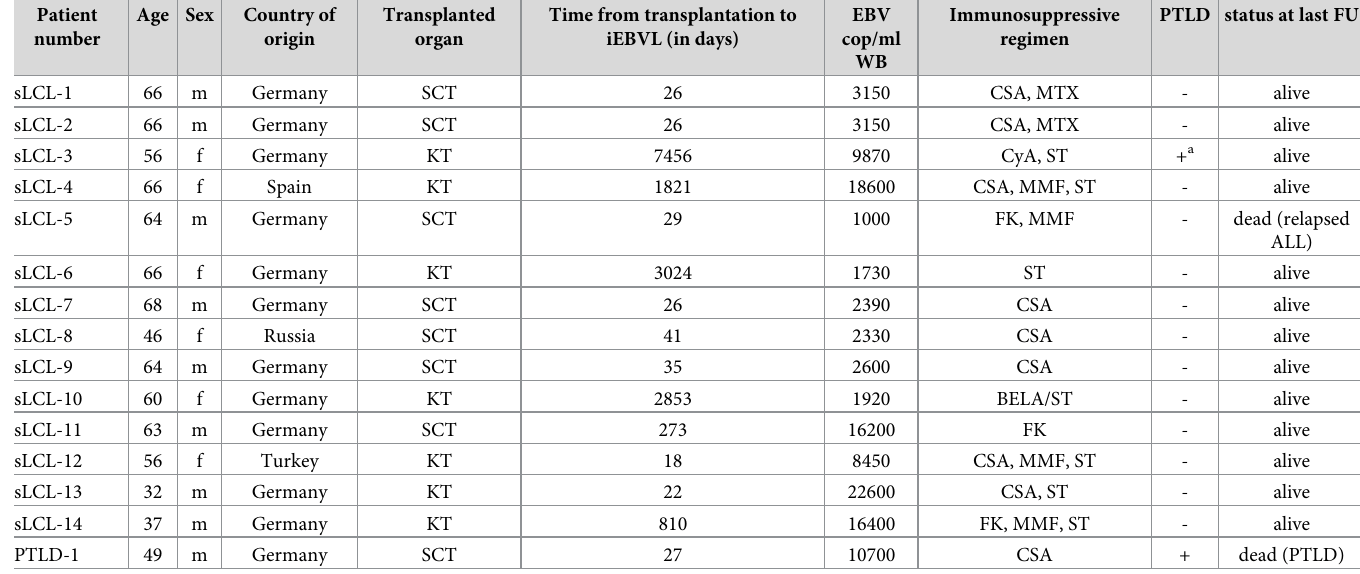
Table 1. Characteristics of the studied patients (sLCL-1 to-14) with an iEBVL and one patient with a post-transplant lymphoproliferative disorder